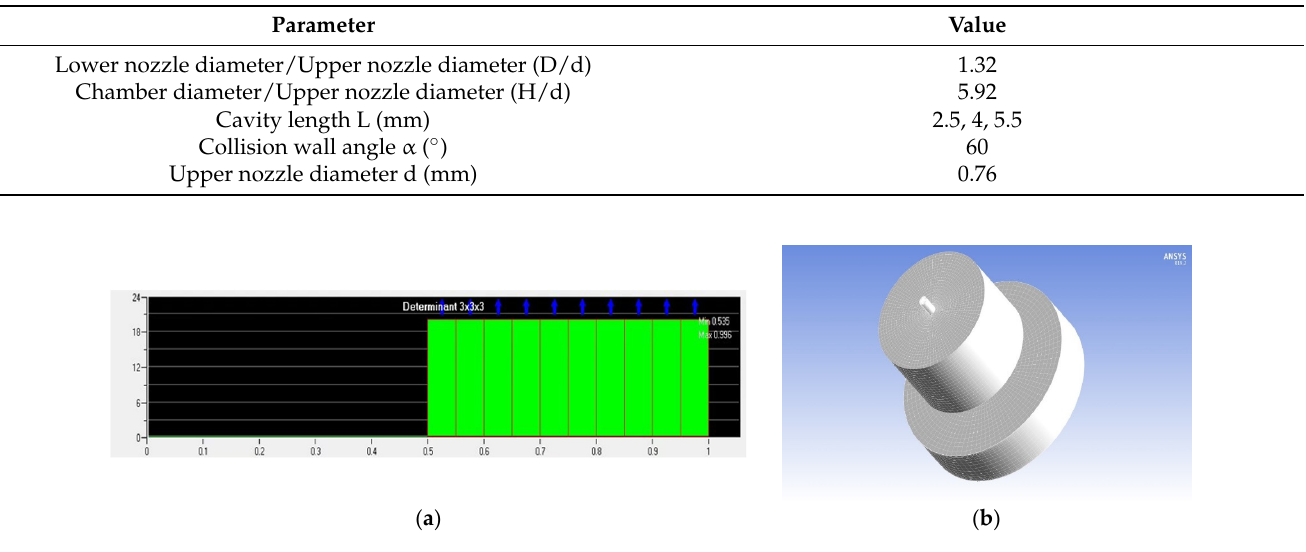
Figure 1. Self-excited oscillating cavity structure and boundary setting. Two-dimensional cavity structure ( a ). Three-dimensional boundary conditions ( b ). Table 1. Main structural parameters of the self-excited oscillation cavity [23].